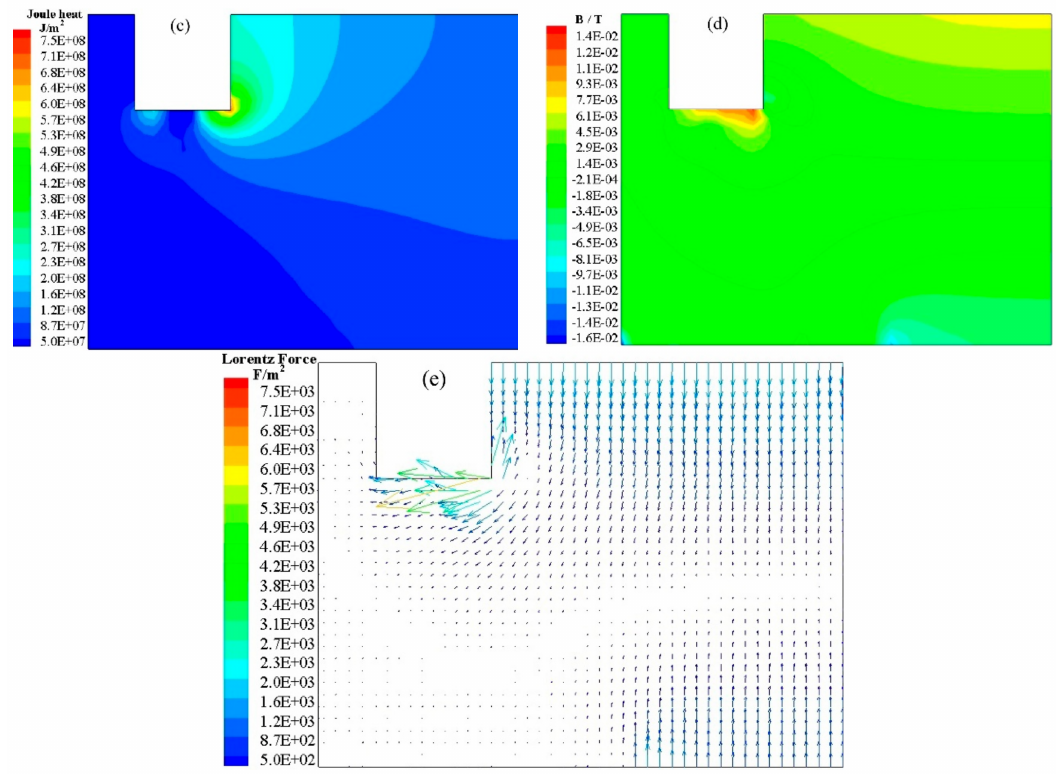
Figure 4. Contours of the parameters in the slag bath: ( a ) Voltage; ( b ) current density; ( c ) joule heat, ( d ) magnetic flux density; ( e ) Lorentz